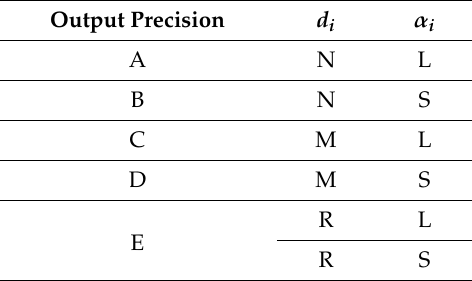
Table 1. Fuzzy rules for proposed FCL.